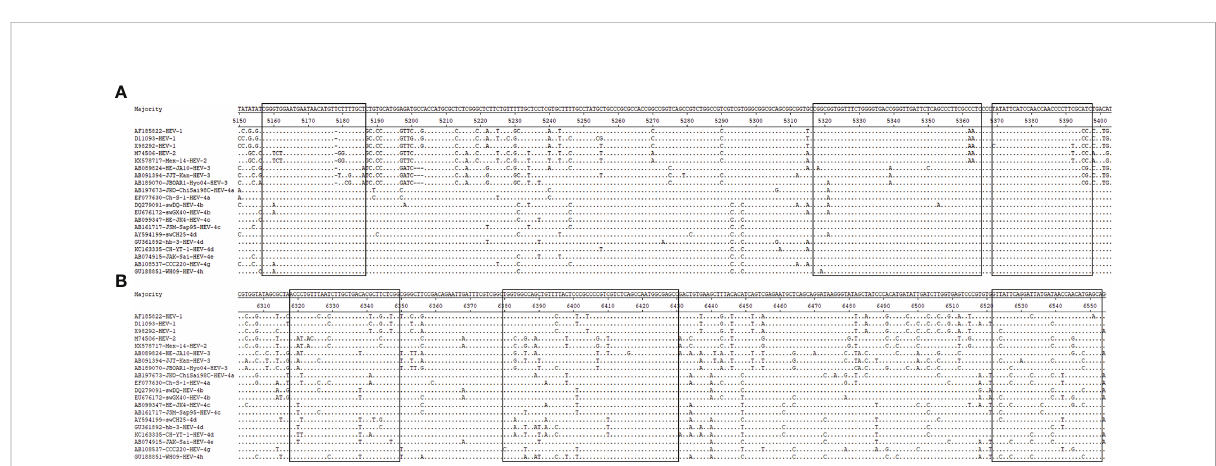
FIGURE 3 Primer and probe positions within ORF2 gene of HEV genotypes 1 – 4. The un fi lled boxes represent the primer regions used in this study. Nucleotide residues that match the majority are indicated by dots; nucleotide deletions are indicated by dashes. (A) Primers and probes used for the RT-qRPA assay. (B) Primers and probes used for the LFB RT-RPA assay.